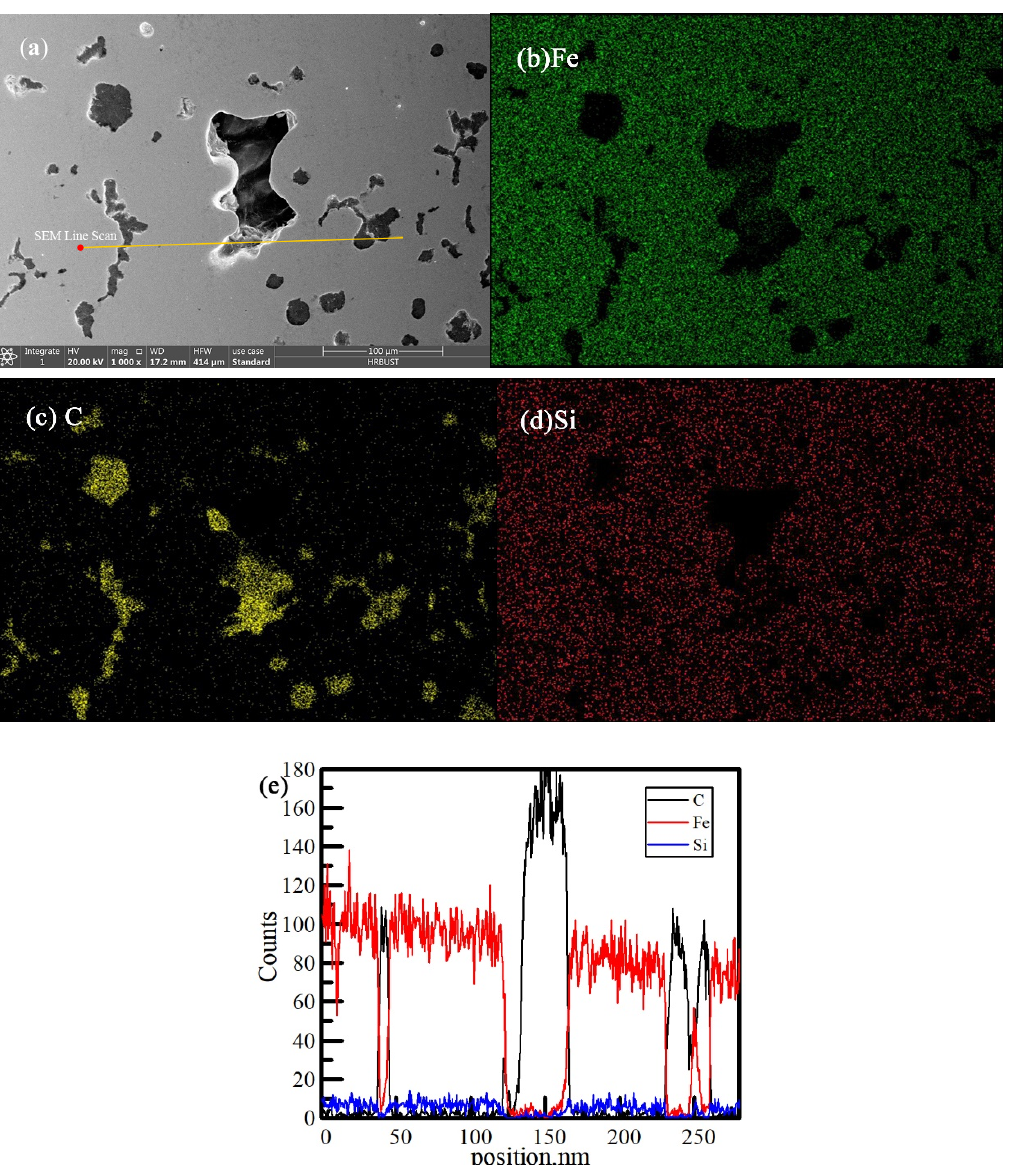
Figure 11. EDS analysis of shrinkage in compacted graphite iron: ( a ) shrinkage morphology and line scan path, ( b ) Fe element distribution, ( c ) C element distribution, ( d ) Si element distribution, and ( e ) line scan curve.